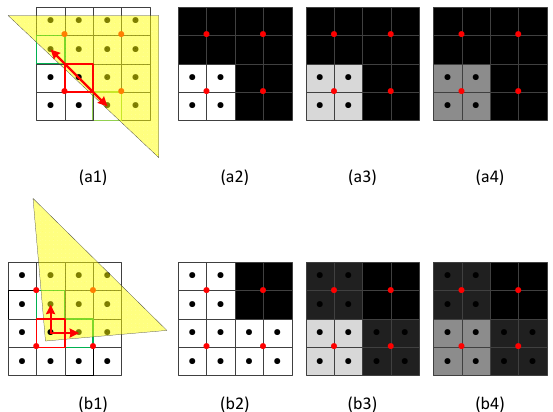
Figure 5. The continuous edges. The red point is the pixel center, and the black is the sub-pixel center. ( a1 ) and ( b1 ) are the different cases of the four pixels and sixteen sub-pixels covered by a yellow fragment. ( a2 ) and ( b2 ) are no anti-aliasing. ( a3 ) and ( b3 ) are the common sub-pixel anti-aliasing. ( a4 ) and ( b4 ) are our method to deal with the sub-pixel anti-aliasing.